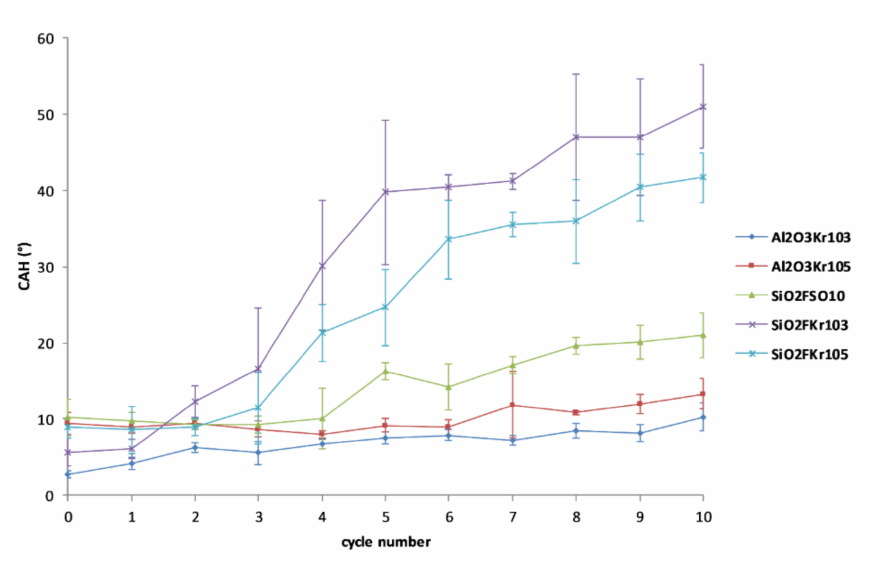
Figure 10. Contact angle hysteresis (CAH) as a function of the freeze/thawing cycle number. Stan- dard deviations are reported as error